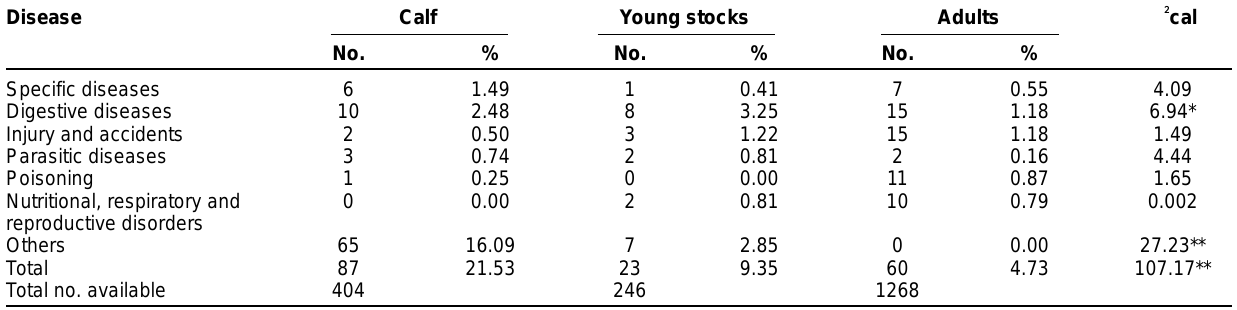
Table-2.2. Sex wise mortality rate in bovine Disease